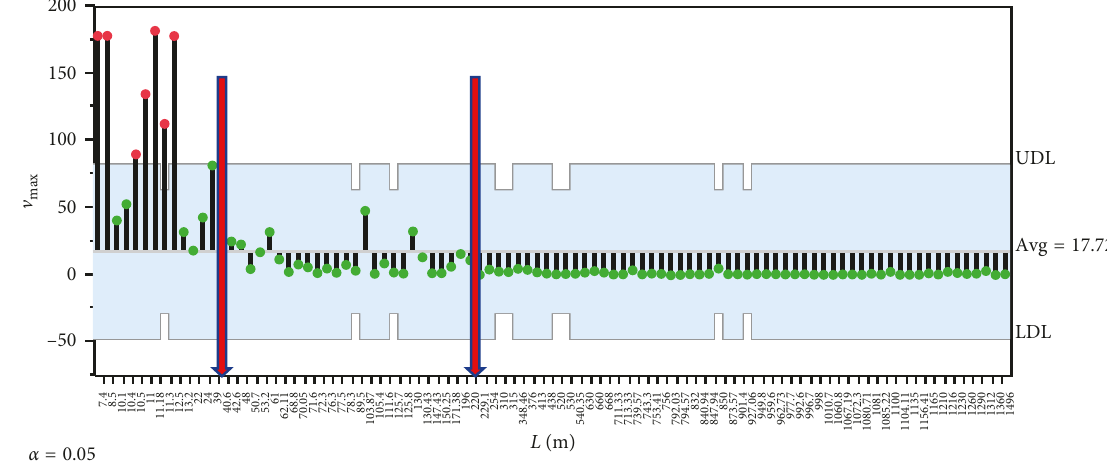
Figure 7: Analysis of average maximum speeds according to a distance of measurement. Table 1: ANOVA: type of deposit. Velocity direction